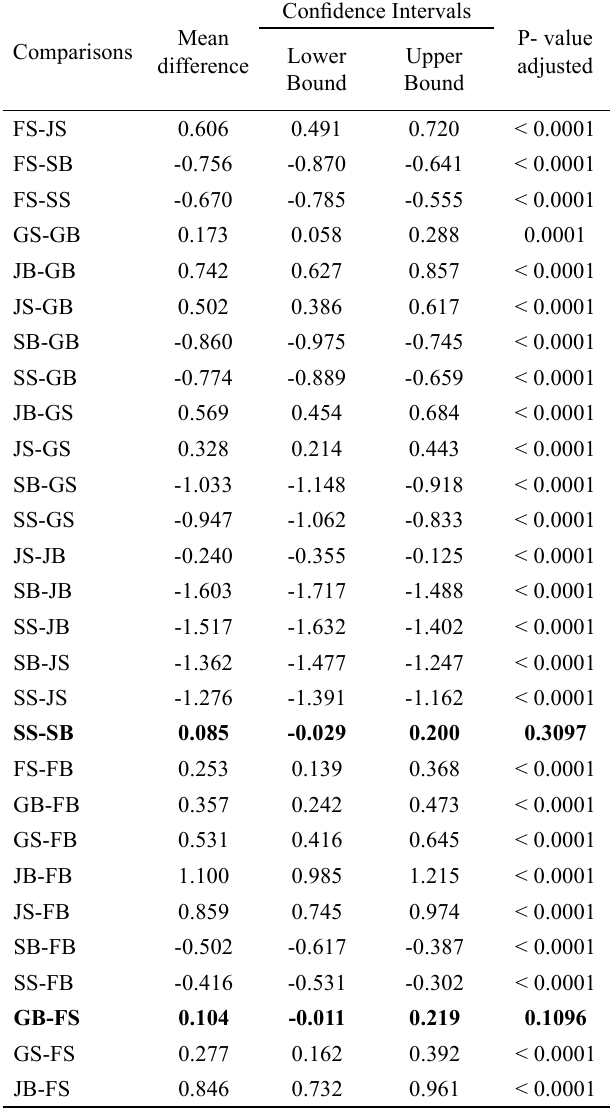
*Significant difference at 95% family-wise confidence level by Tukey HSD test.